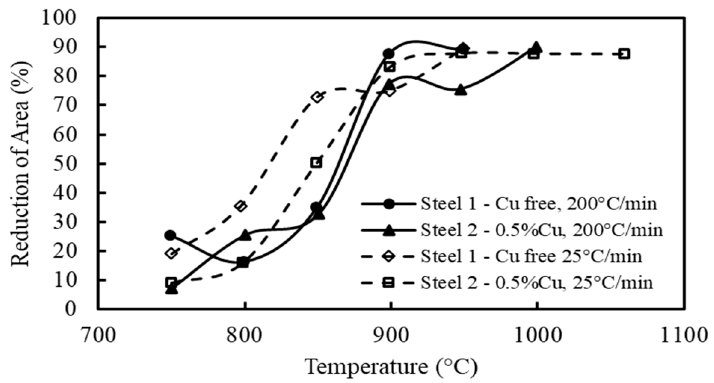
Figure 2. Hot ductility curves for a Cu free steel, steel 1 and a Cu-containing steel, steel 2, tested using two different cooling rates, 25 K/min and 200 K/min in an argon atmosphere,. The tensile specimens were cast in-situ. It can be seen that Cu only causes impairment of ductility at the slower cooling rate.